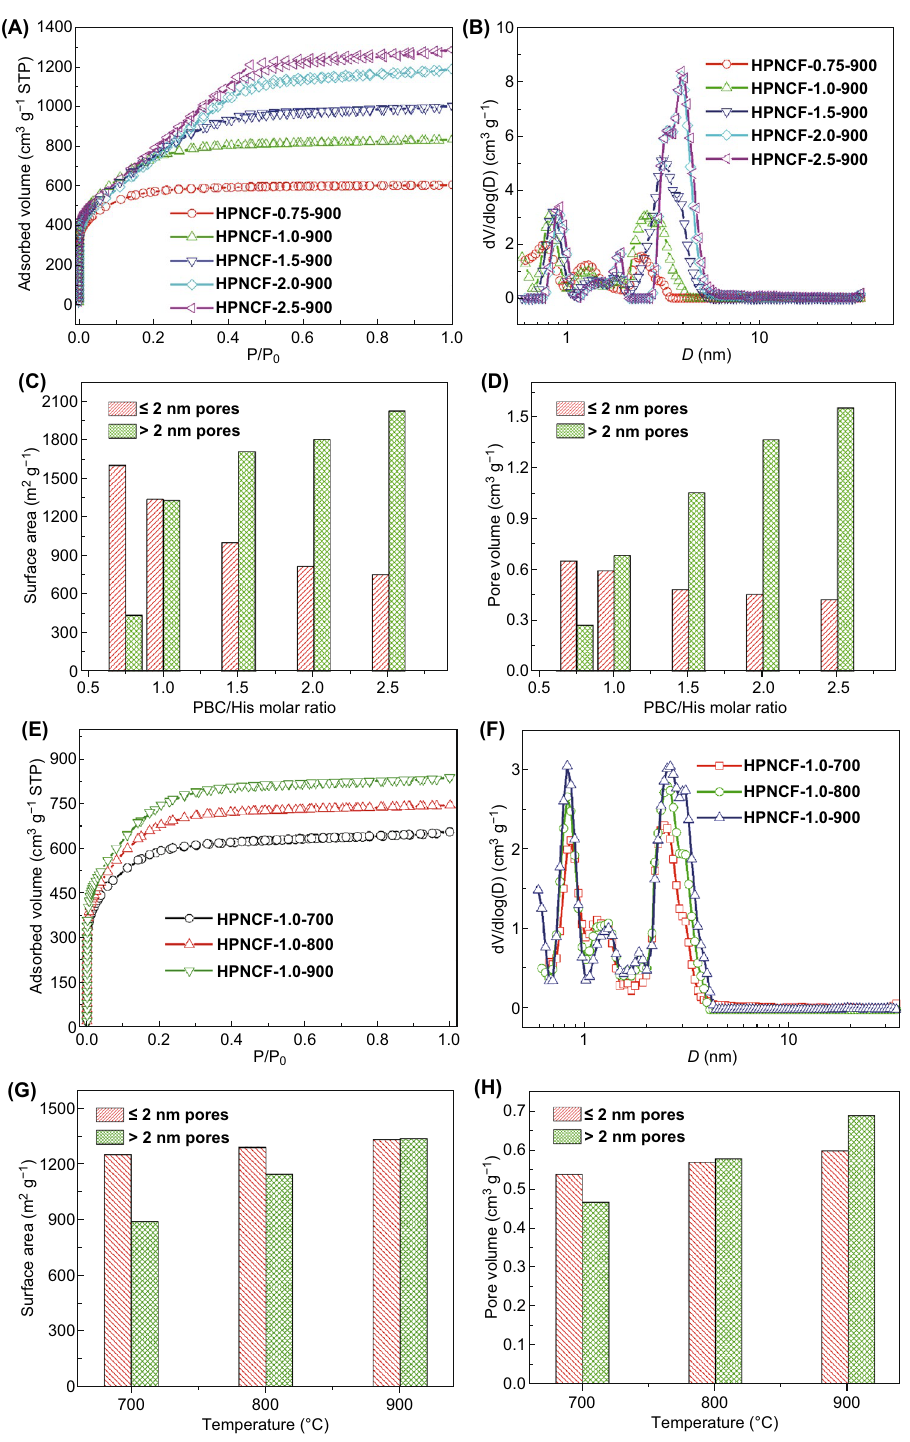
Fig. 5 N 2 sorption isotherms ( A , E ) and the PSD curves ( B , F ) of the HPNCFs obtained at various PBC/His molar ratios and temperatures, and the corresponding pore-size-dependent surface area ( C , G ) and pore volume ( D , H ) variations with the increase in the PBC/His molar ratio at a fixed temperature of 900 °C ( C , D ) and with the increase in temperature at a fixed PBC/His molar ratio of 1.0 ( G , H